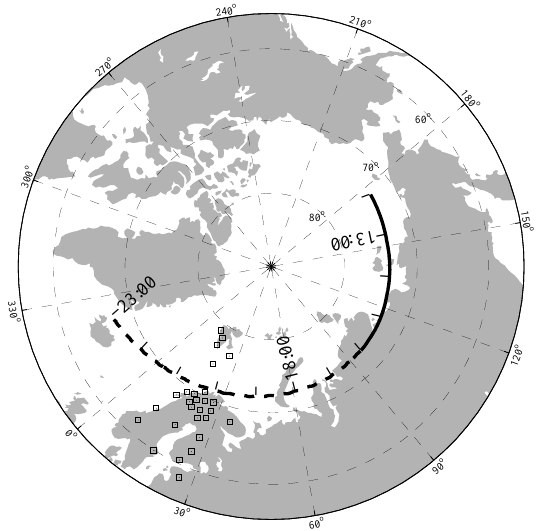
Fig. 1. Cluster footpoints on the ground, fully drawn while Cluster is above the neutral sheet, dashed while below. The IMAGE mag- netometers are marked with squares. Local midnight is down in the figure at the time of substorm onset, 20:39 UT.